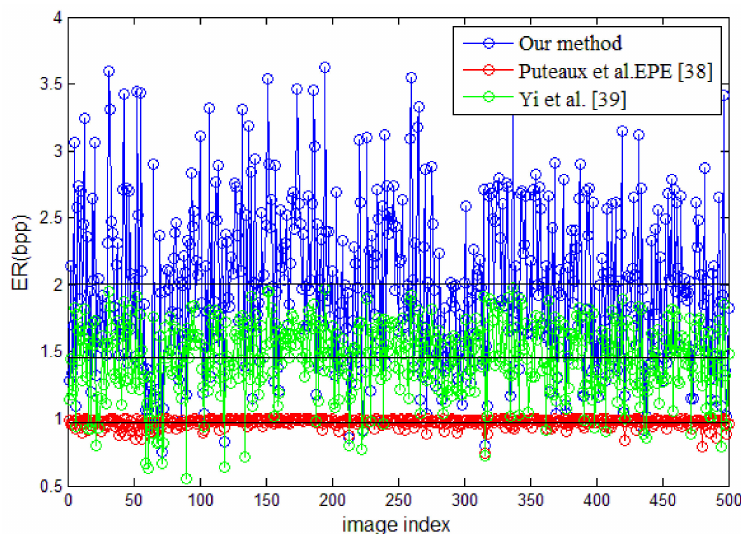
Figure 9. ER comparison with Puteaux et al. EPE [38] and Yi et al. [39] on 500 images, randomly selected from BOWS-2